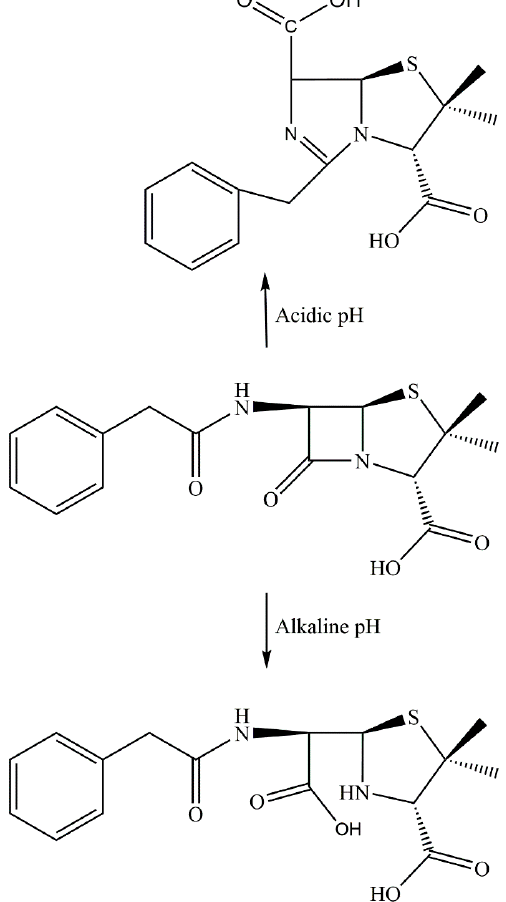
Figure 6. Chemical structures of PG and derived compounds at acidic and alkaline conditions.